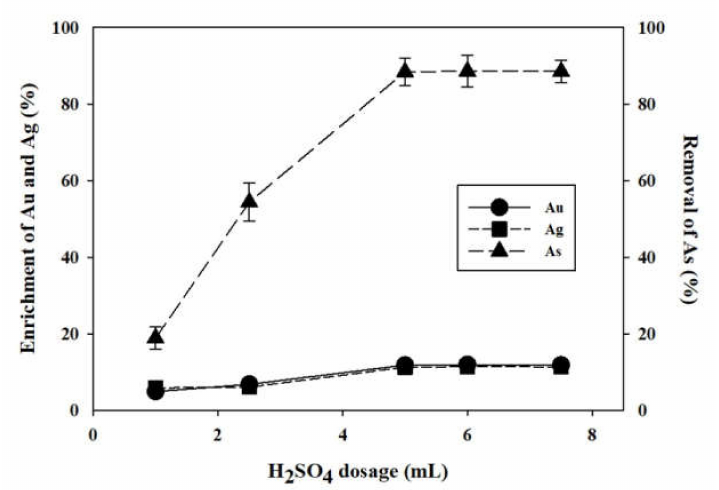
Figure 10. The removal of As and the enrichments of Au and Ag on the solid residue from hot water leaching. H 2 SO 4 dosage (1.0, 2.5, 5.0 6.0, and 7.5 mL); baking temperature, 400 ◦ C; and baking time, 3